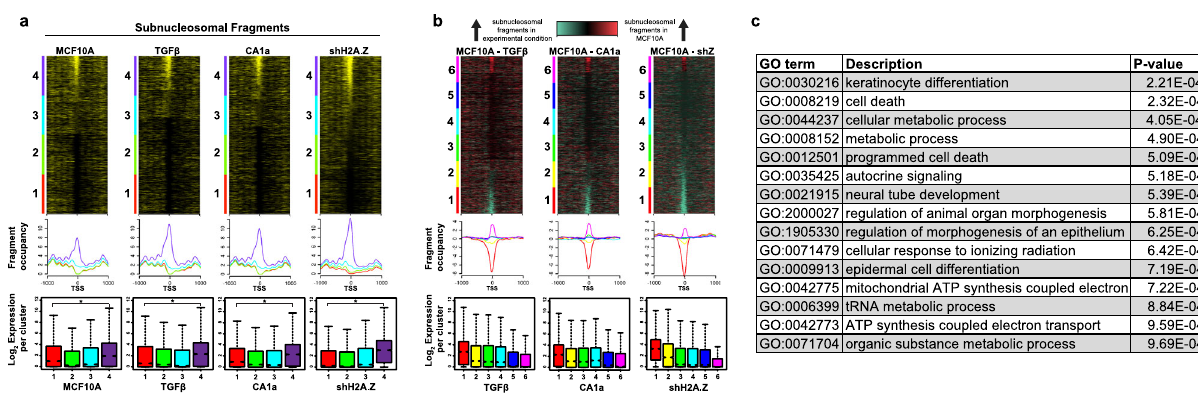
Fig. 5 Subnucleosomal-sized DNA fragments at the TSS is correlated with high levels of gene expression. a Subnucleosomal DNA fragments (<125 bp) were extracted and sorted for the maximum occupancy on 100 bp surrounding the TSS for MCF-10A, MCF-10A + TGF- β , MCF-10CA1a and shH2A.ZMCF- 10A cells to produce heatmaps. The heatmaps were divided into quartiles from high to low occupancy. Below each heatmap are average subnucleosomal DNA fragment occupancy and gene expression box plots for each quartile. Box plots represent the data in quartiles with the median shown as a notch, with the middle 50% of the data contained in the box, and the minima and maxima shown with the upper and lower whiskers representing Q1 and Q4. RNA-seq was performed in three independent biological replicates. b Total subnucleosomal fragments from each experimental condition, MCF-10A + TGF- β , MCF- 10CA1a cells and shH2A.ZMCF-10A, were each independently subtracted from total subnucleosomal fragments in MCF-10A and the resulting difference matrix was used to produce a differential heatmap. Red and cyan coloured SFs at the TSS indicate more abundant subnucleosomal DNA fragments in MCF- 10A cells or more abundant subnucleosomal DNA fragments in the matched experimental condition, respectively. Below each heatmap are average subnucleosomal DNA fragment occupancy and gene expression box plots for each sextile. Box plots represent the data in quartiles with the median shown as a notch, with the middle 50% of the data contained in the box, and the minima and maxima shown with the upper and lower whiskers representing Q1 and Q4. RNA-seq was performed in three independent biological replicates. c Gene ontology analysis of 110 genes of interest using the GOrilla algorithm, p -values are determined by hypergeometric null model as described in Eden et al. 65 .